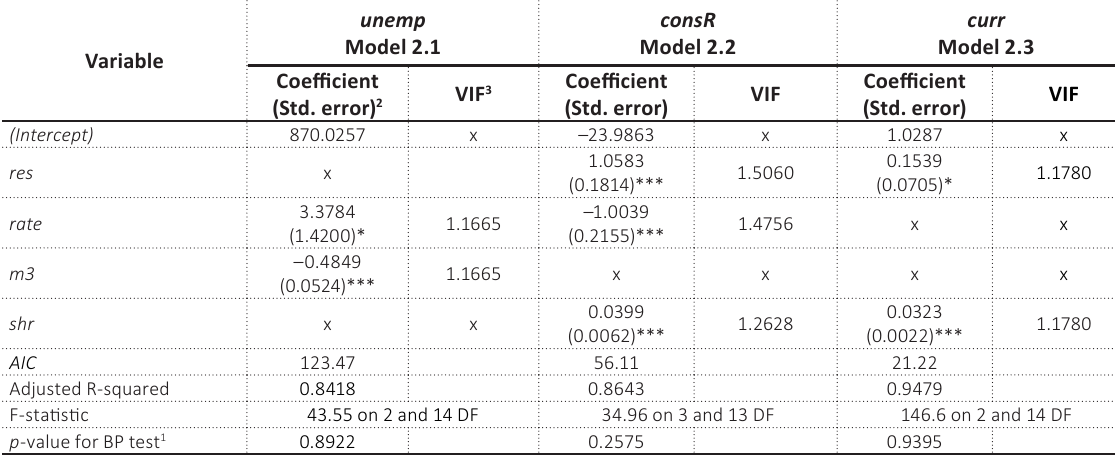
Table 5. Summary statistics for transmission models of inflation targeting in Ukraine (periods when cpi > 2%)